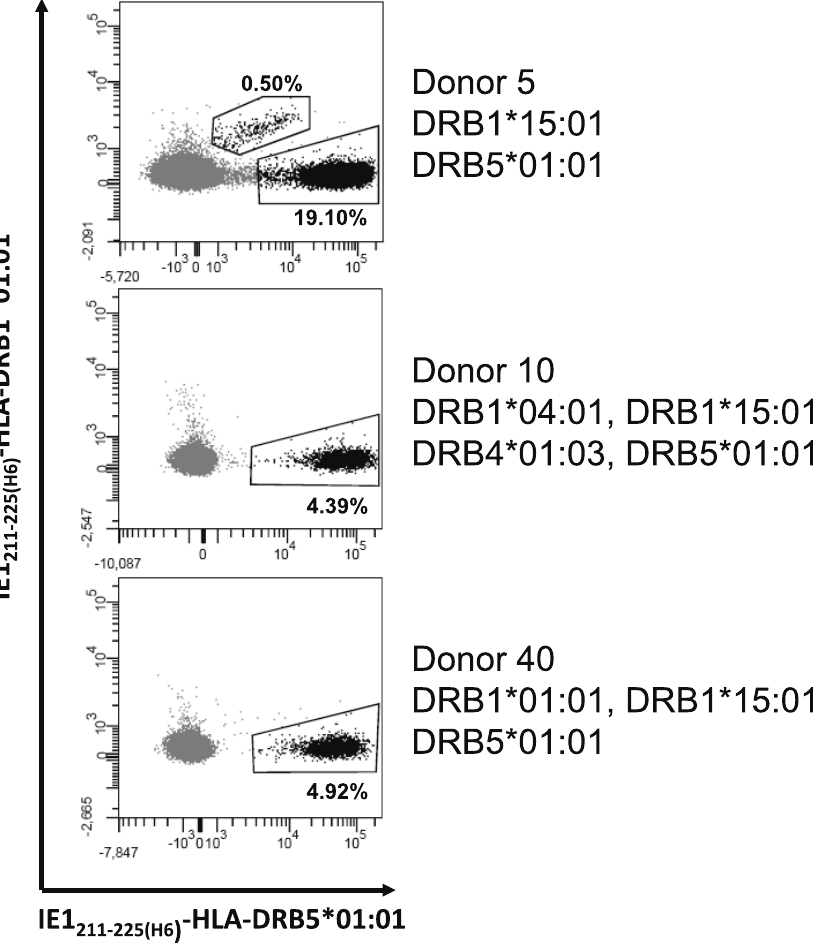
Figure 4. Double staining with different MHC class II tetramers. Flow cytometry plots of combined stainings with DRB1*01:01-IE1 211–225(H6) tetramer and DRB5*01:01-IE1 211–225(H6) tetramer of in vitro cultured PBMCs from three donors. Unexpectedly the DRB1*01:01-IE1 211–225(H6) tetramer stained 0.5% CD4 + T cells in donor 5 although this donor did not express this allele. Double staining with DRB1*01:01-IE1 211–225(H6) and DRB5*01:01- IE1 211–225(H6) tetramer reveals that 0.5% of the much larger population recognizing IE1 211–225 on DRB5*01:01 cross-recognize the epitope on